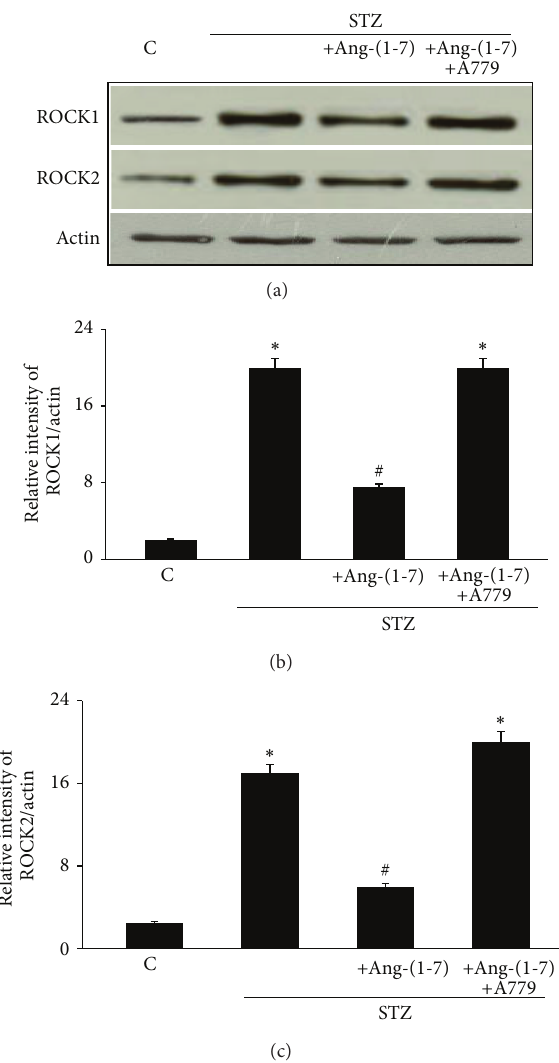
Figure 5: The levels of ROCK1 and ROCK2 protein expression in corpus cavernosum of nondiabetic (C), diabetic (STZ), and STZ-rats chronically treated either with Ang-(1-7) alone (STZ + Ang-(1-7)) or in combination with A779 (STZ + Ang-(1-7) + A779). Panel (a) is a representativewesternblotshowingthelevelsofROCK1,ROCK2,andtheproteinloadingcontrol, 𝛽 -actin.Panels(b)and(c)aredensitometry histograms showing levels of ROCK1 and ROCK2 normalized to actin, respectively. 𝑁 = 4 ; Mean ± SD. Asterisk ( ∗ ) indicates significantly different ( 𝑃 < 0.05 ) mean values from normal nondiabetic rats (C), whereas hash (#) indicates significantly different mean values ( 𝑃 < 0.05 ) from diabetic rats